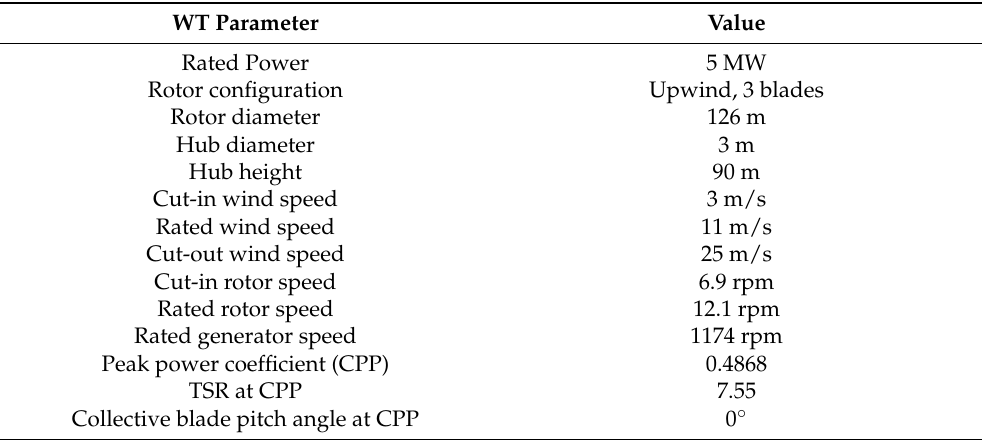
Table 1. NREL 5 MW offshore WT